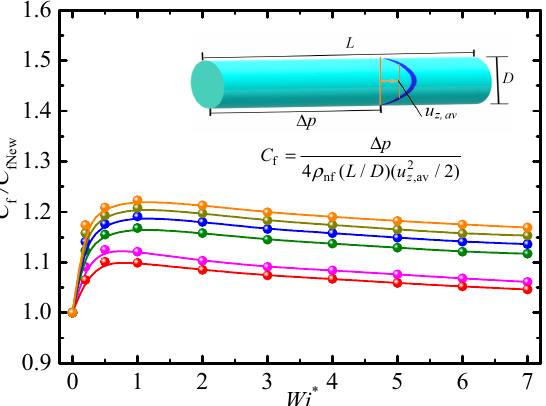
Figure 4. Friction factor vs. modified Weissenberg number for different particle concentrations ( β 0 = 0.2, Re = 2.5, α = 0.2). ⸺ ● ⸺ : Φ = 0% (Giesekus fluid) [27]; ⸺ ● ⸺ : Φ =0% (Giesekus fluid); ⸺ ● ⸺ : Φ =0.5%; ⸺ ● ⸺ : Φ = 1.0%; ⸺ ● ⸺ : Φ = 2.0%; and ⸺ ● ⸺ : Φ = 3.0%.